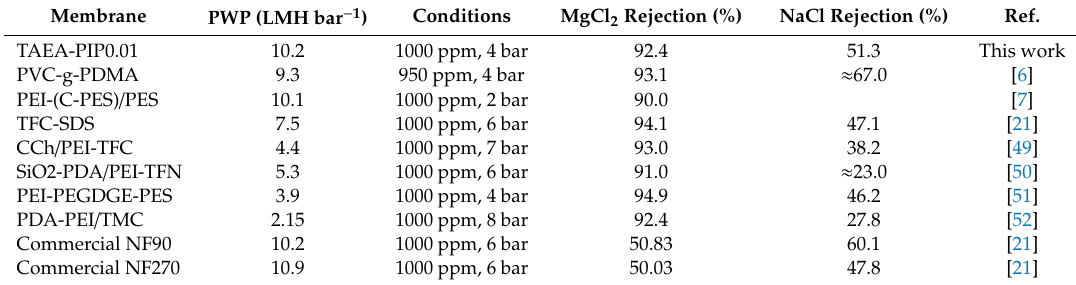
Table 1. Comparison of TAEA-PIP0.01 NF membrane with state-of-the art works.